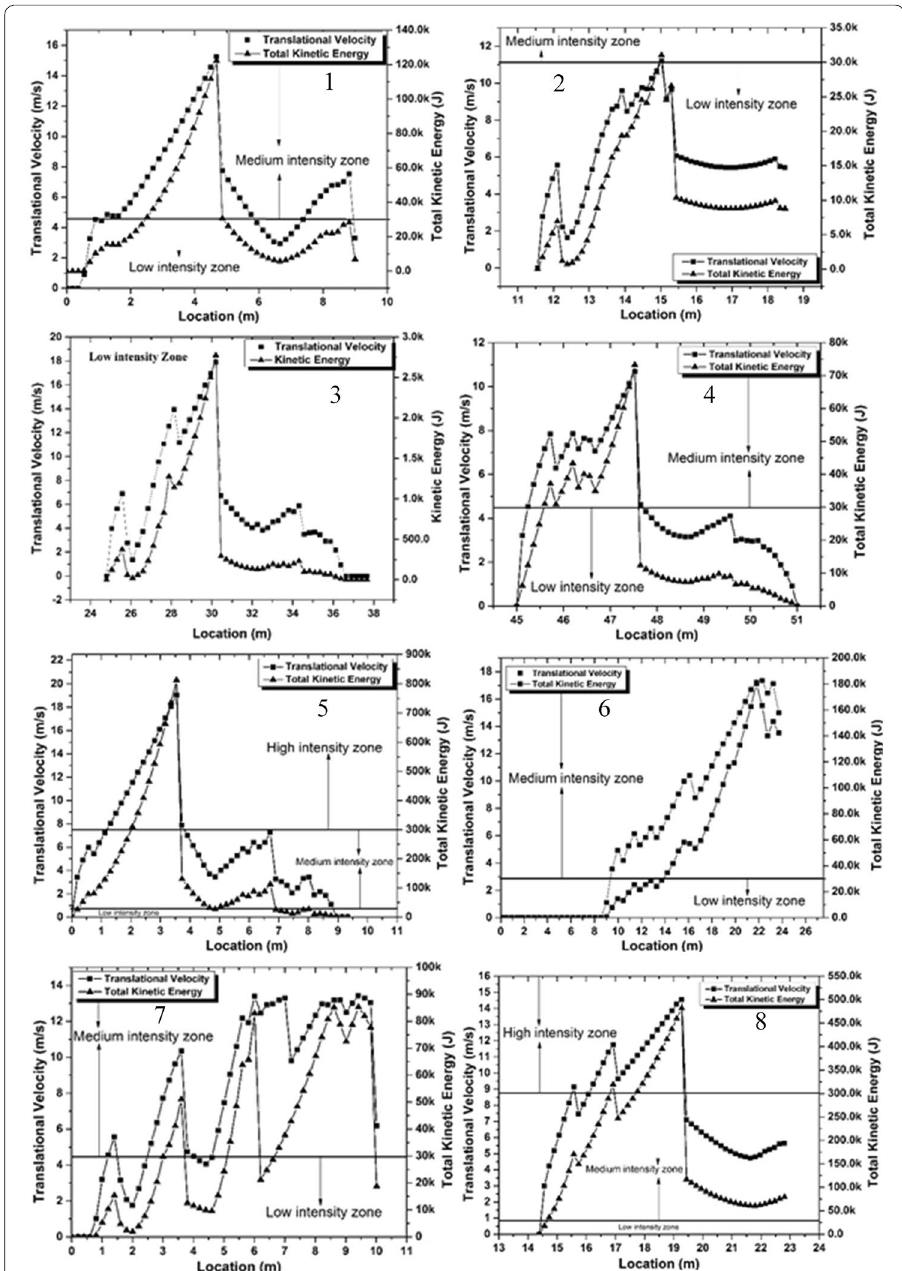
Fig. 7 Translational velocity and total kinetic energy for the analyzed cut slope